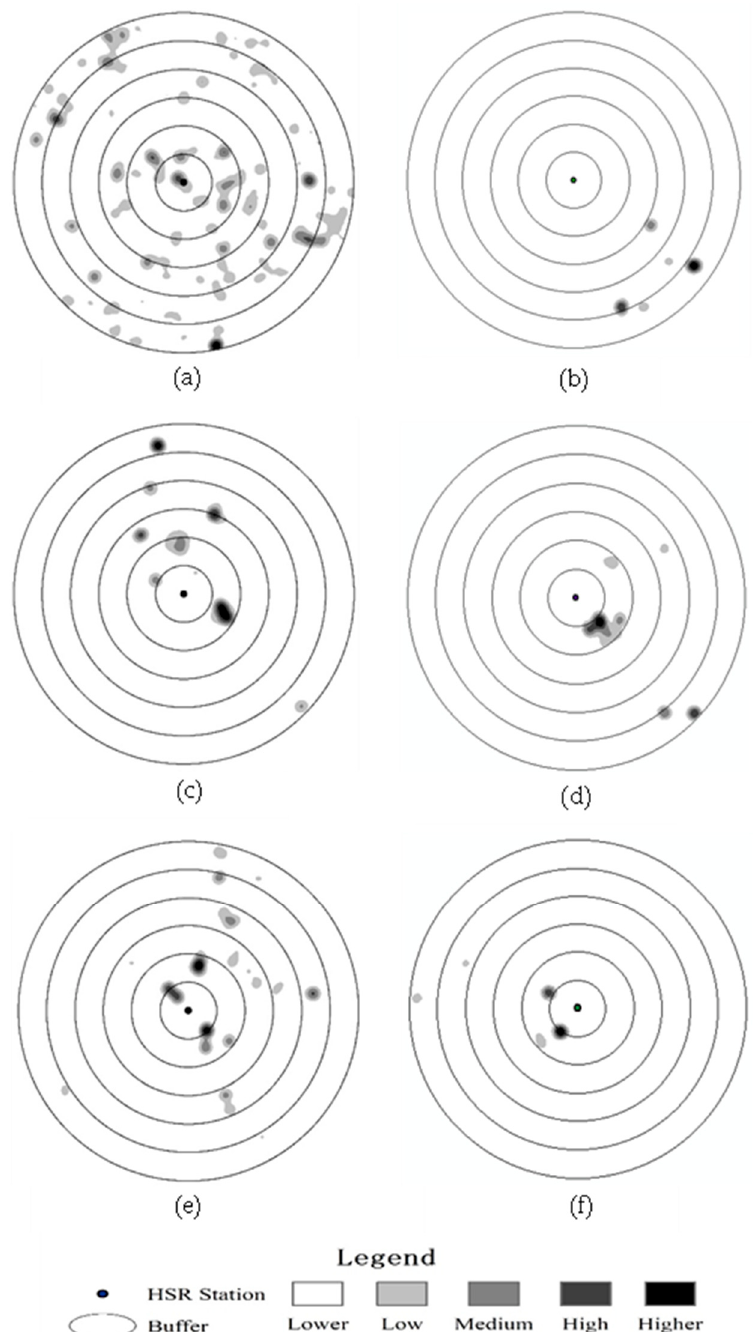
Figure 2. Kernel density estimation results of accommodation facilities: ( a ) Beijingnan; ( b ) Tianjinxi; ( c ) Nanjingnan; ( d ) Jinanxi; ( e ) Kunshannan; ( f ) Xuzhoudong.